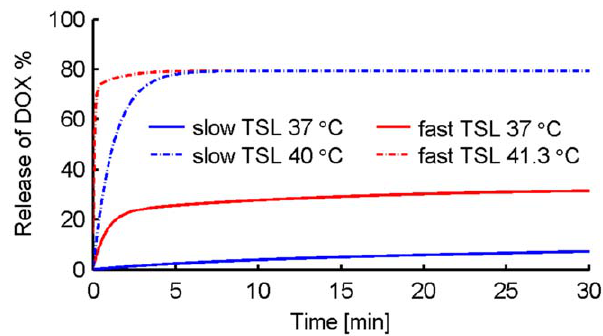
Figure 1. Release of DOX from different TSL at normal body temperature of 37 6 C and at , 42 6 C. Release data adapted